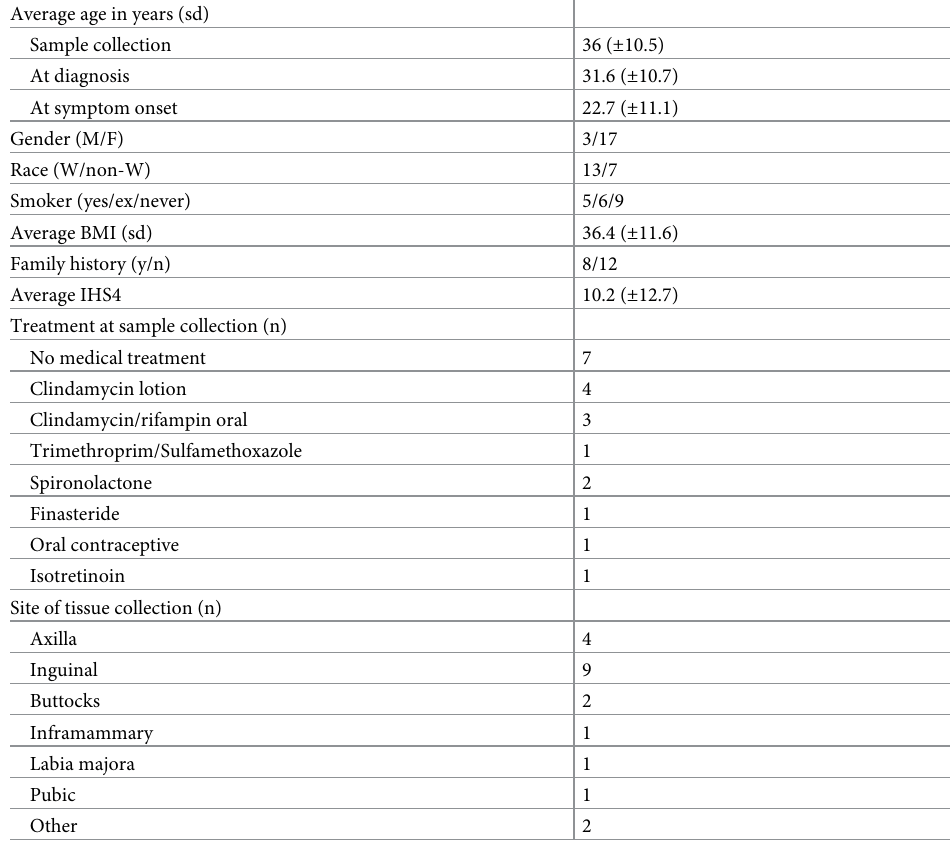
Table 1. Demographic characteristics of the hidradenitis suppurativa 20 patient